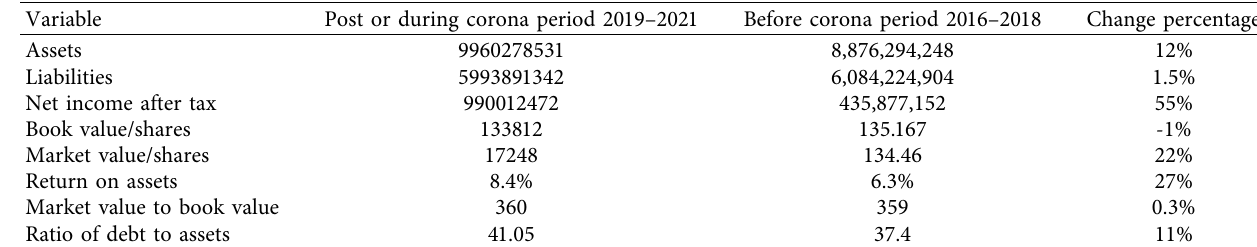
Table 9: Summary of tables for study variables.